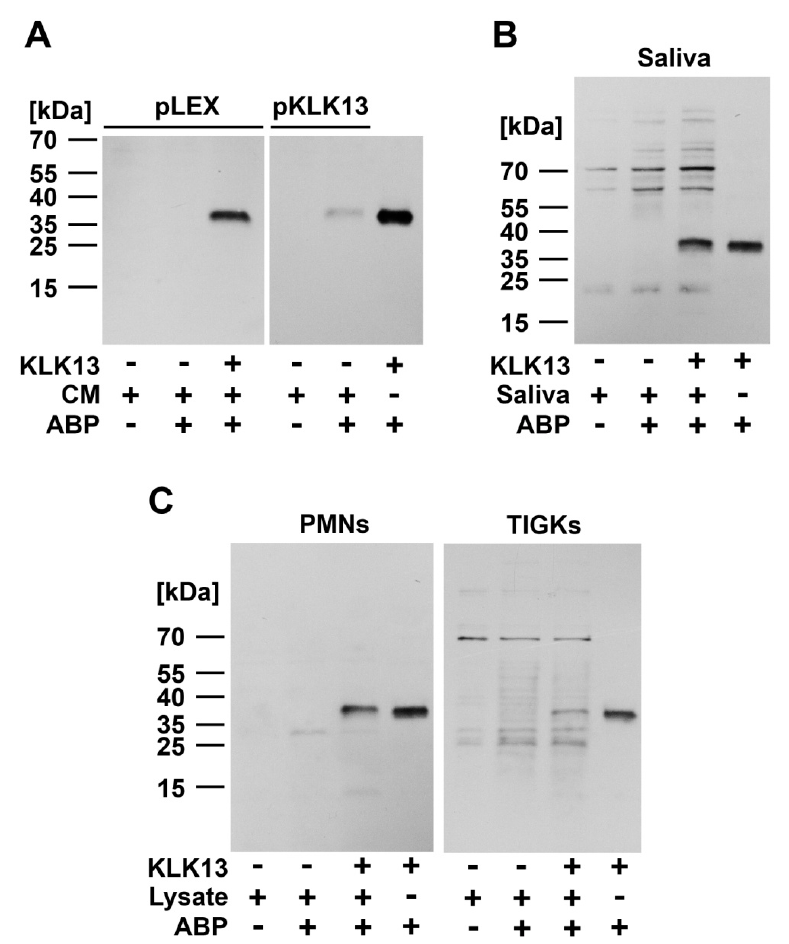
Figure 4. Bt-PEG-VRFR-CMK detection of KLK13 in biological samples. Effectiveness of the KLK13 probe was tested in the background of different media and cell lysates using Western blot. ( A ) Conditioned culture media (CM) of Leishmania Expression System (LEXSY) strains stably transfected with either empty pLEX or pLEXpKLK13 plasmids were preincubated with or w / o 1 μ M KLK13 probe for 1 h at 37 °C. KLK13 was detected in the presence of ABP only in the media from cells transfected with pKLK13 and in the media of empty pLEX culture spiked with 250 ng KLK13; ( B ) Saliva was freshly collected from healthy volunteers. Diluted samples were either vehicle-treated or spiked with 250 ng of KLK13 and incubated with or without addition of 1 μ M specific KLK13 probe. Signal corresponding to KLK13 was detected exclusively in the KLK13-spiked sample in the presence of ABP; ( C ) 30 μ g of PMNs RIPA buffer cell lysate and 5 μ g of TIGK cell lysate were either vehicle-treated or spiked with 250 ng of KLK13 and were incubated with or without the addition of 1 μ M specific KLK13 probe. Signal corresponding to the KLK13 molecular weight was detected in the KLK13-spiked samples in the presence of ABP. In addition, a lower-molecular weight band of unknown origin was detected in probe treated cell lysate.